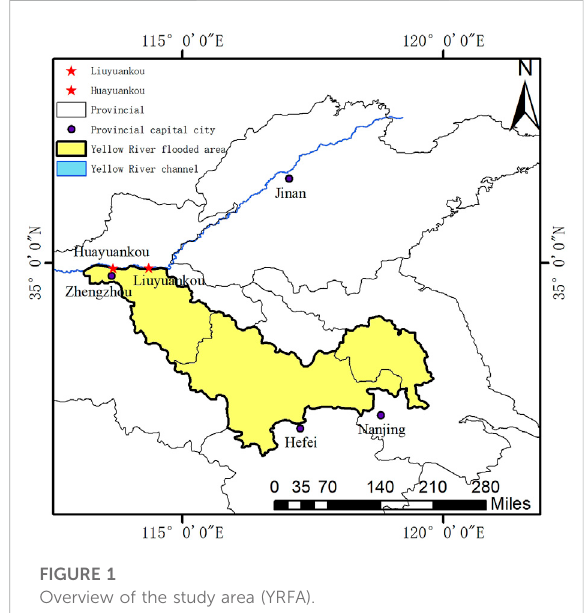
FIGURE 1 Overview of the study area